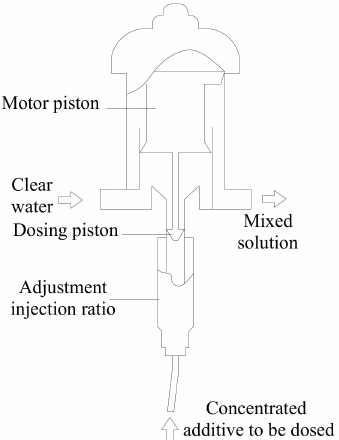
Figure 1. Schematic diagram of proportional injector (PI).